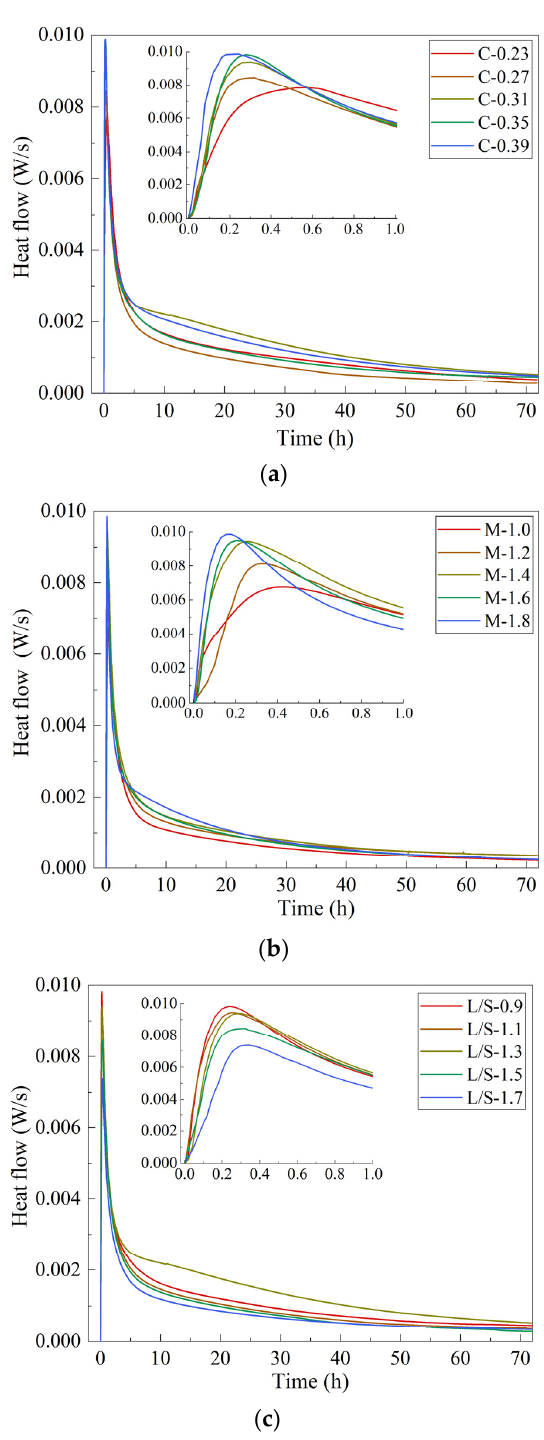
Figure 1. Heat evolution curves of MK-GGBFS geopolymer synthesized with varying alkaline activator concentrations ( a ), moduli ( b ), and L/S ratios ( c ). Table 3. Total heat released during the first 72 h.